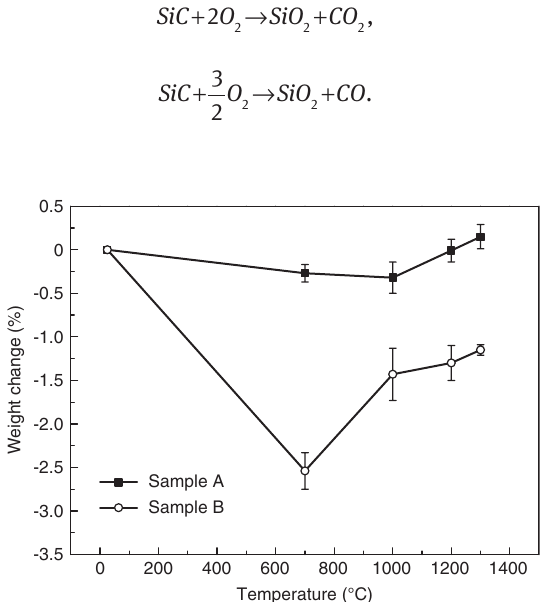
coating for sample B (Figure 2B). Determined through SEM observation, the SiC coating microcracks density ( ∼ 50 cracks/m) for sample A is much lower than that ( ∼ 1090 cracks/m) for sample B, as shown in Table 2. Furthermore, the coating microcracks width ( ∼ 1 μ m) for sample B is five times larger than that ( ∼ 0.2 μ m) for sample A determined from Figure 2A and B.